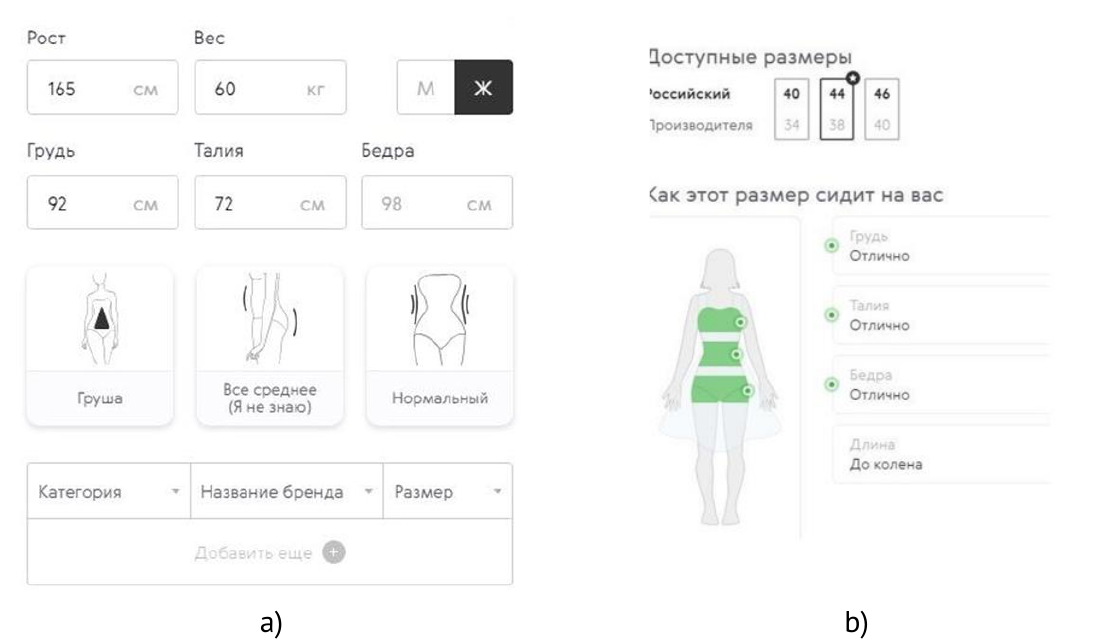
Figure 2. The result of the virtual fitting with the use of the Sizolution